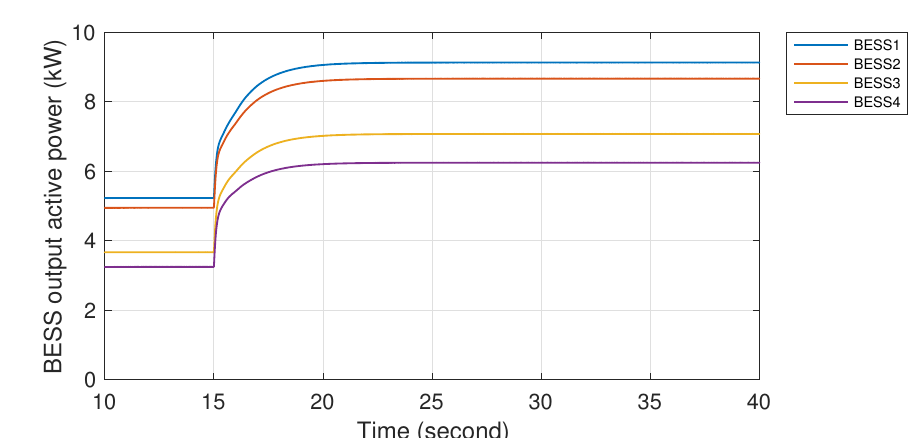
Figure 16. BESSs’ active